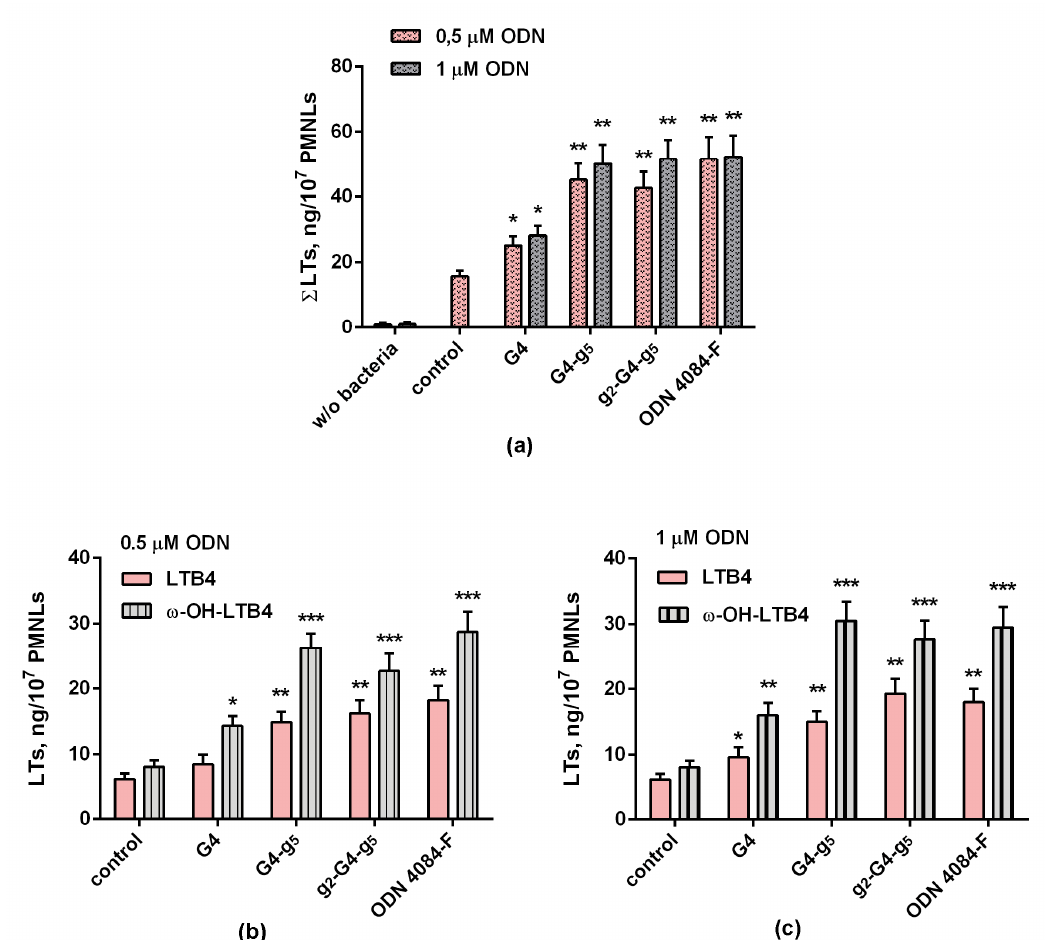
Figure 3. Leukotriene synthesis in human PMNLs in the presence of ODNs. PMNLs (2 × 10 7 ) were incubated for 15 min at 37 °C without (control) or with ODNs, as indicated, and then (3–5) × 10 8 S. typhimurium bacteria were added for 15 min. The 5-lipoxygenase (5-LOX) products were extracted from the medium and separated using HPLC. Σ LTs; the sum of Leukotriene B4 (LTB4), its isomers, and ω -OH-LTB4. Presented are effects of ODNs on the formation of the Σ LTs ( a ) and on LTB4 and ω -OH-LTB4 synthesis at 0.5 µM ODN ( b ) or 1 µM ODN ( c ) exposure. Values indicate mean ± SEM of five independent experiments performed in duplicate. * p < 0.05, ** p < 0.01, compared to the control probe without ODN.